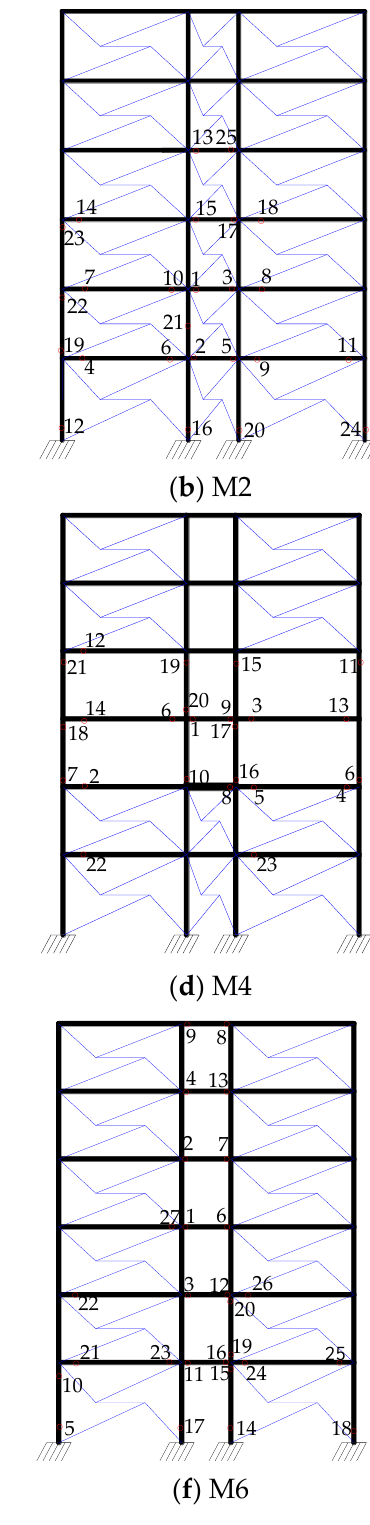
Figure 10. Plastic hinge distribution of six models. (Note: red circles represent plastic hinges. )